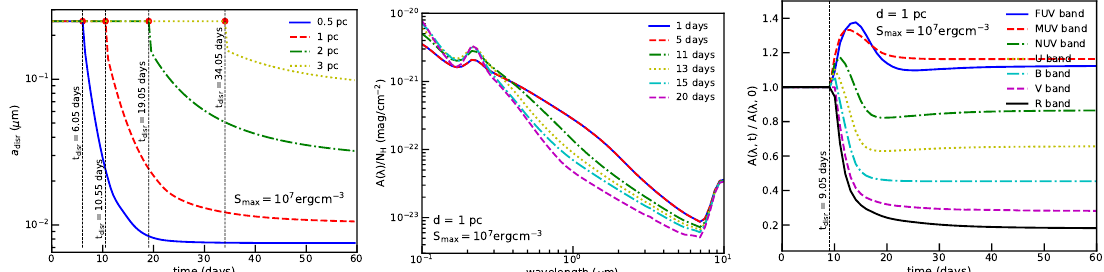
Figure 18. Left panel: Disruption sizes vs. time for dust grains at different distances. Middle panel: Extinction curves evaluated at different times for S max = 10 7 ergcm − 3 , assuming the dust cloud at 1 pc from SNe Ia. Optical-NIR extinction decreases while UV extinction increases over time due to RATD. Right panel: Variation of A ( λ , t ) / A ( λ ,0 ) from FUV-R bands with time. Vertical lines mark the disruption time of graphite which occurs earlier than silicates. The ratio is constant initially and starts to vary with time when RATD begins at t disr . After the disruption ceases, the ratio is constant again. From Giang et al. [91].